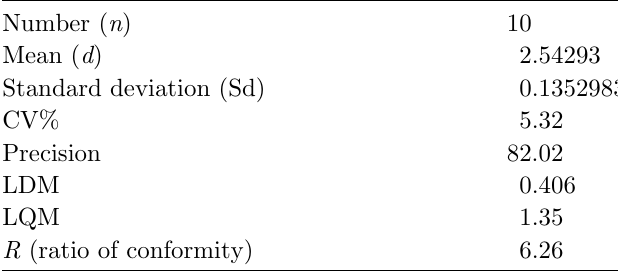
Table 7. Limit of detection and limit of quanti fi cation data of a method for the quantitation of Ecstasy in seizures by UV-Vis spectrophotometer [15].